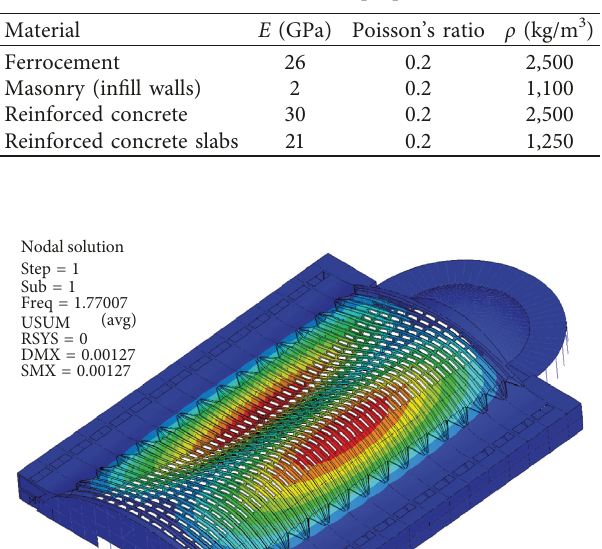
Table 1: Materials and properties.